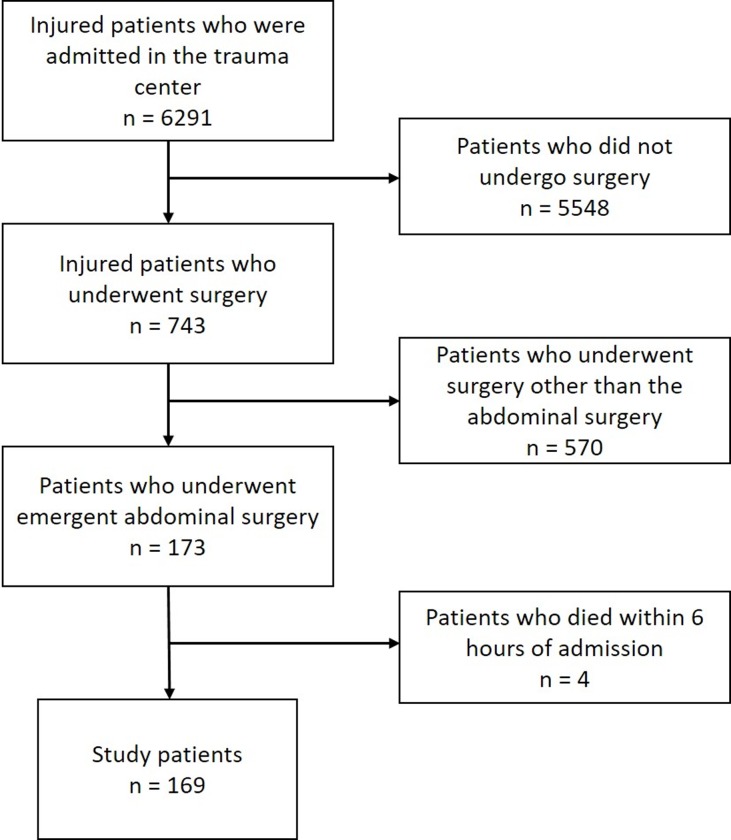
Patient flow chart.